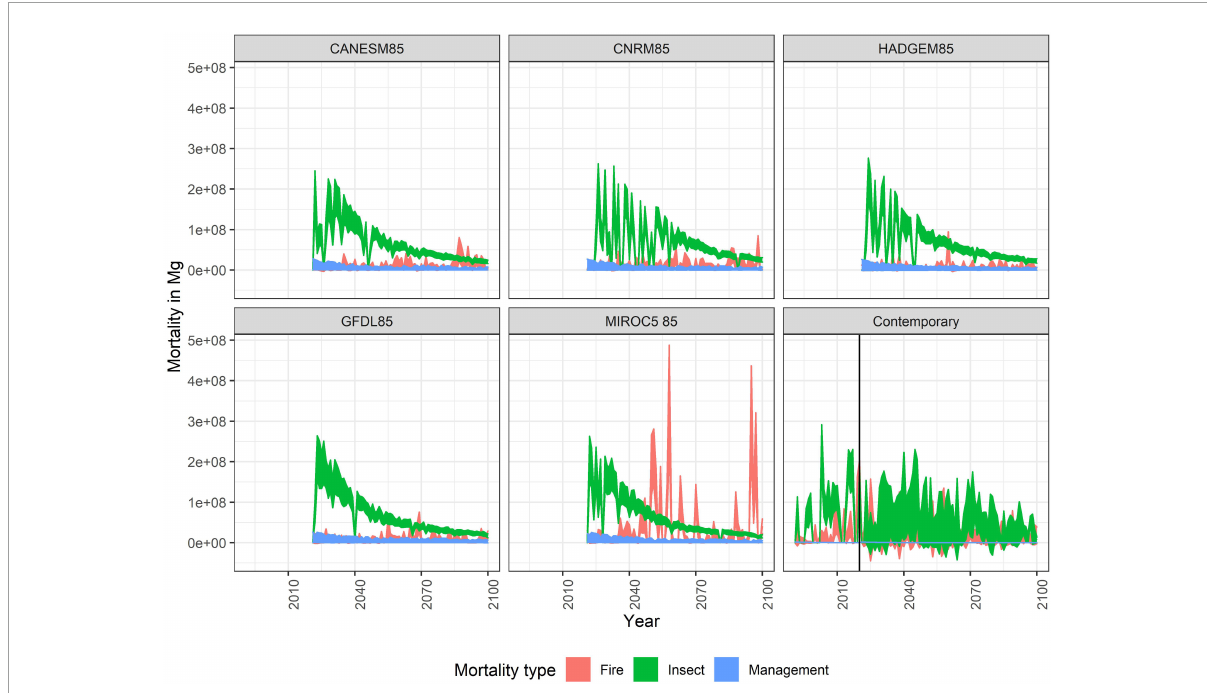
FIGURE3 Cumulative forest mortality by disturbance type in Mg Biomass. Management includes harvesting, thinning, and prescribed fire.